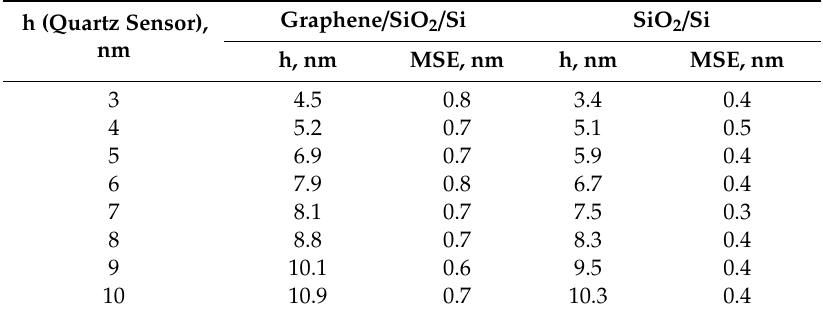
Table 1. Measured thicknesses of gold films using AFM in comparison with quartz sensor readings in an electron beam evaporation